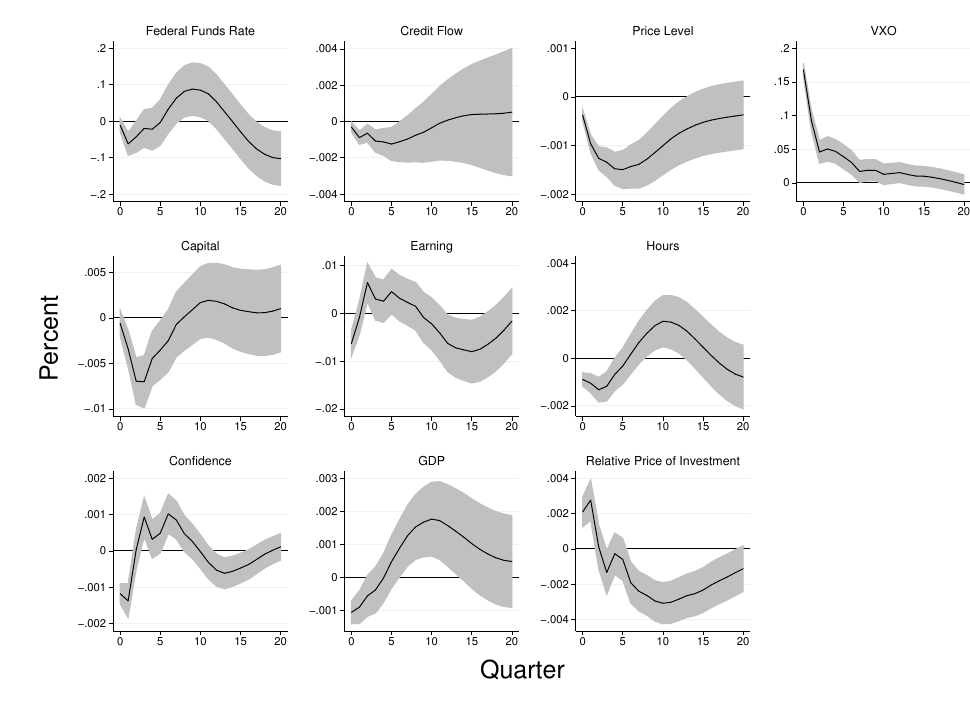
Figure A7. Uncertainty Shocks and Business Confidence. Notes : Shaded regions represent 95 percent standard error bands. The data are quarterly and span the period 1986Q1-2019Q4. With the exception of the federal funds rate, all the other variables are in log levels.